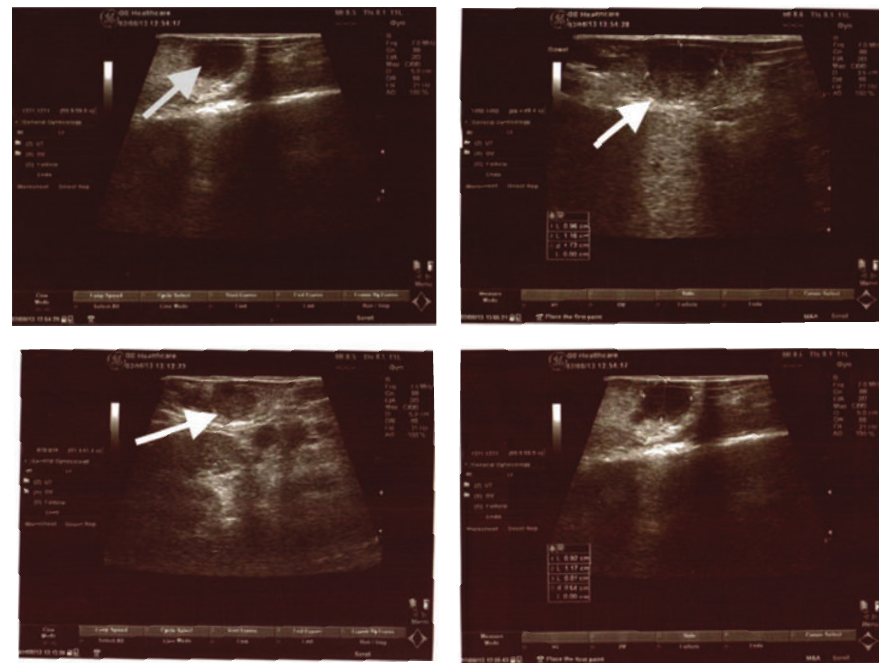
Figure 3: Intraoperative ultrasonography images.